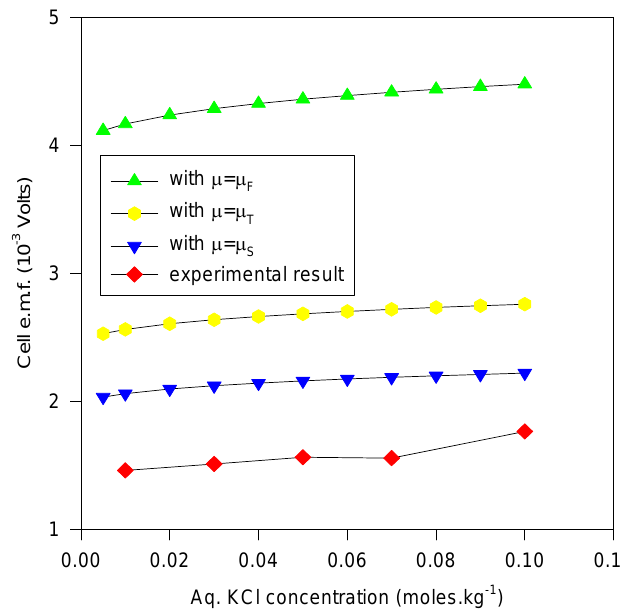
O dielectric constant 2